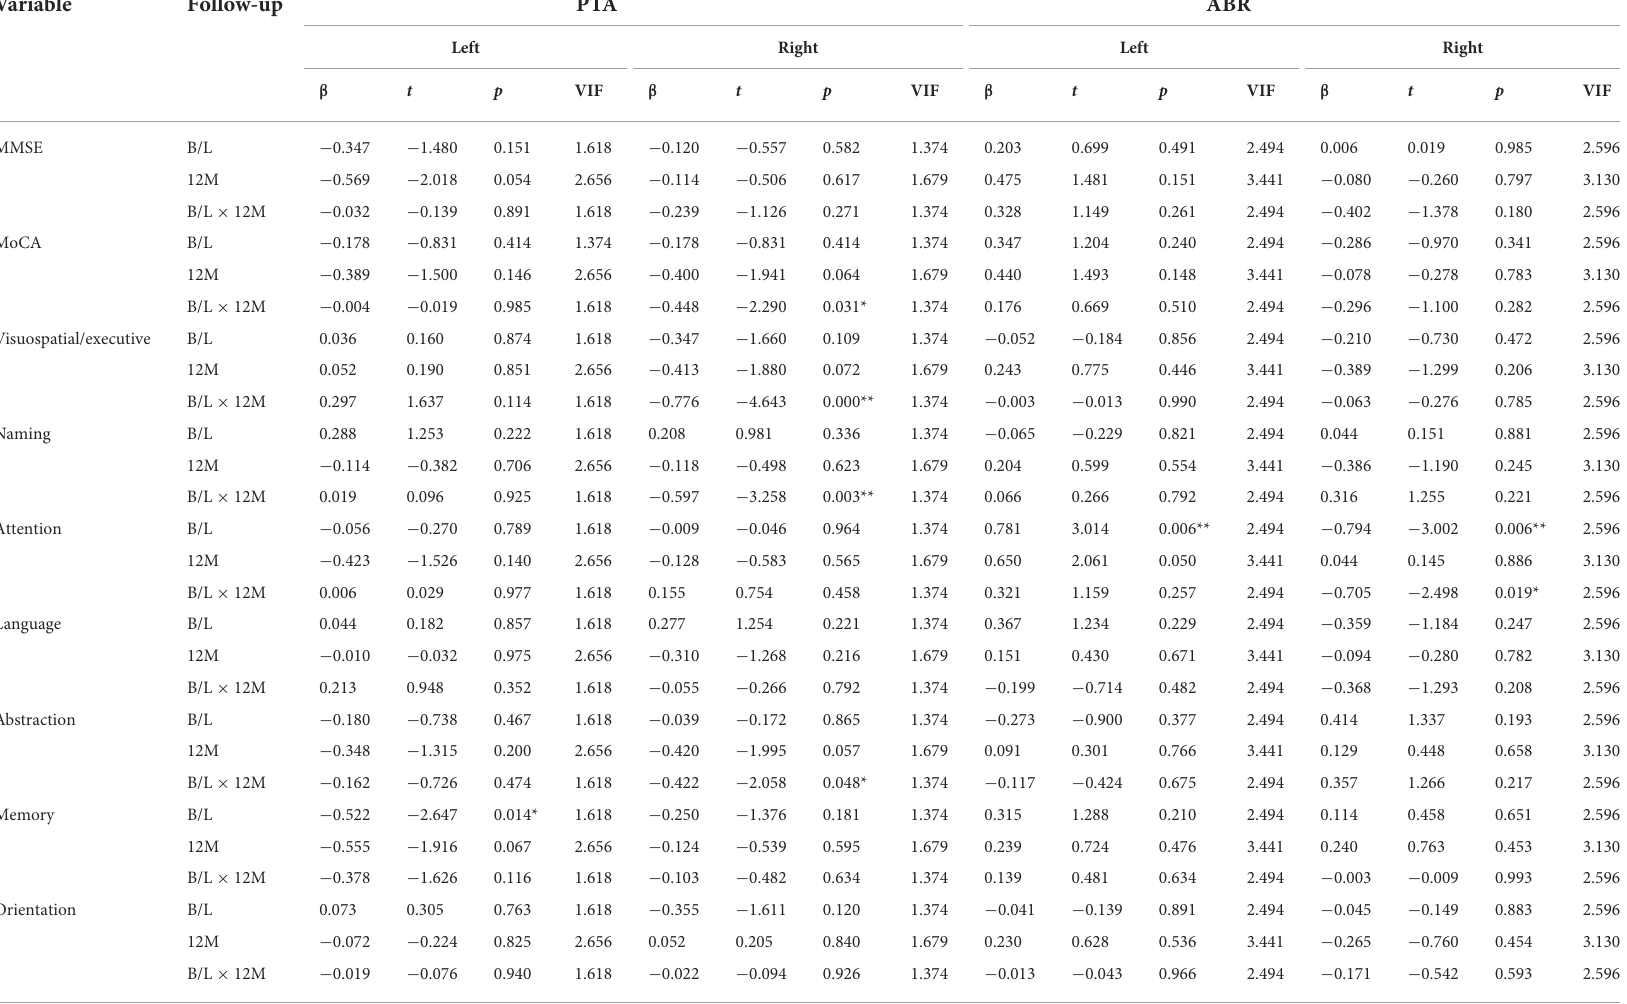
TABLE 3 Multiple linear regression analysis of hearing and cognitive functions in the MCI-HI group.